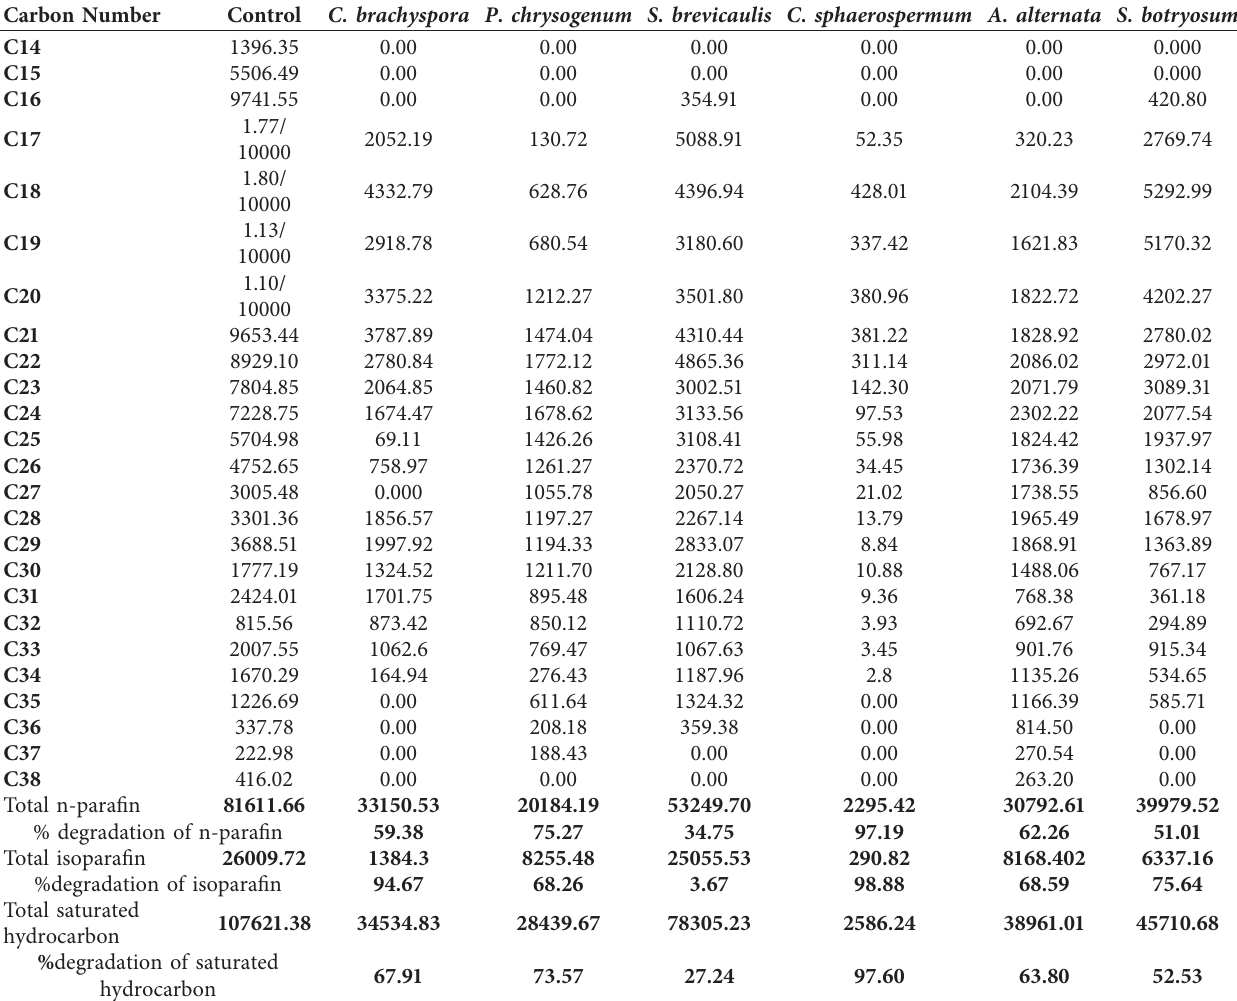
Table 1: Quantitative degradation analysis, estimated by GC, of saturated hydrocarbons using six fungal species corresponding to untreated